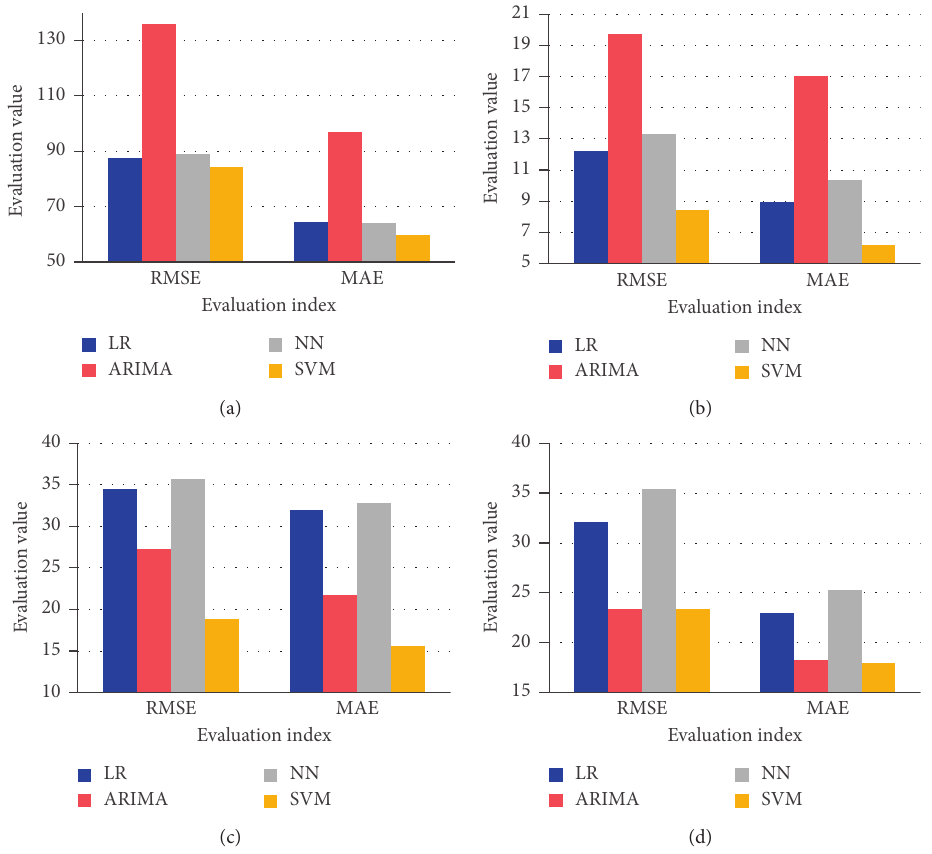
Figure 4: Comparison among the four prediction models using FM1. (a) Forecasting result of commercial parks using FM1. (b) Forecasting result of office parks using FM1. (c) Forecasting result of small-scale parks using FM1. (d) Forecasting result of medium-scale parks using